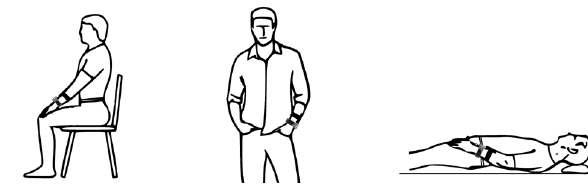
Fig. 3. Setup for the validation data collection. One minute recordings were taken with the participant in three positions: 1) sitting, 2) standing, and 3) lying down. The recordings were repeated once after resting and once after one minute of exercise. The Galaxy Gear was worn on the left wrist.